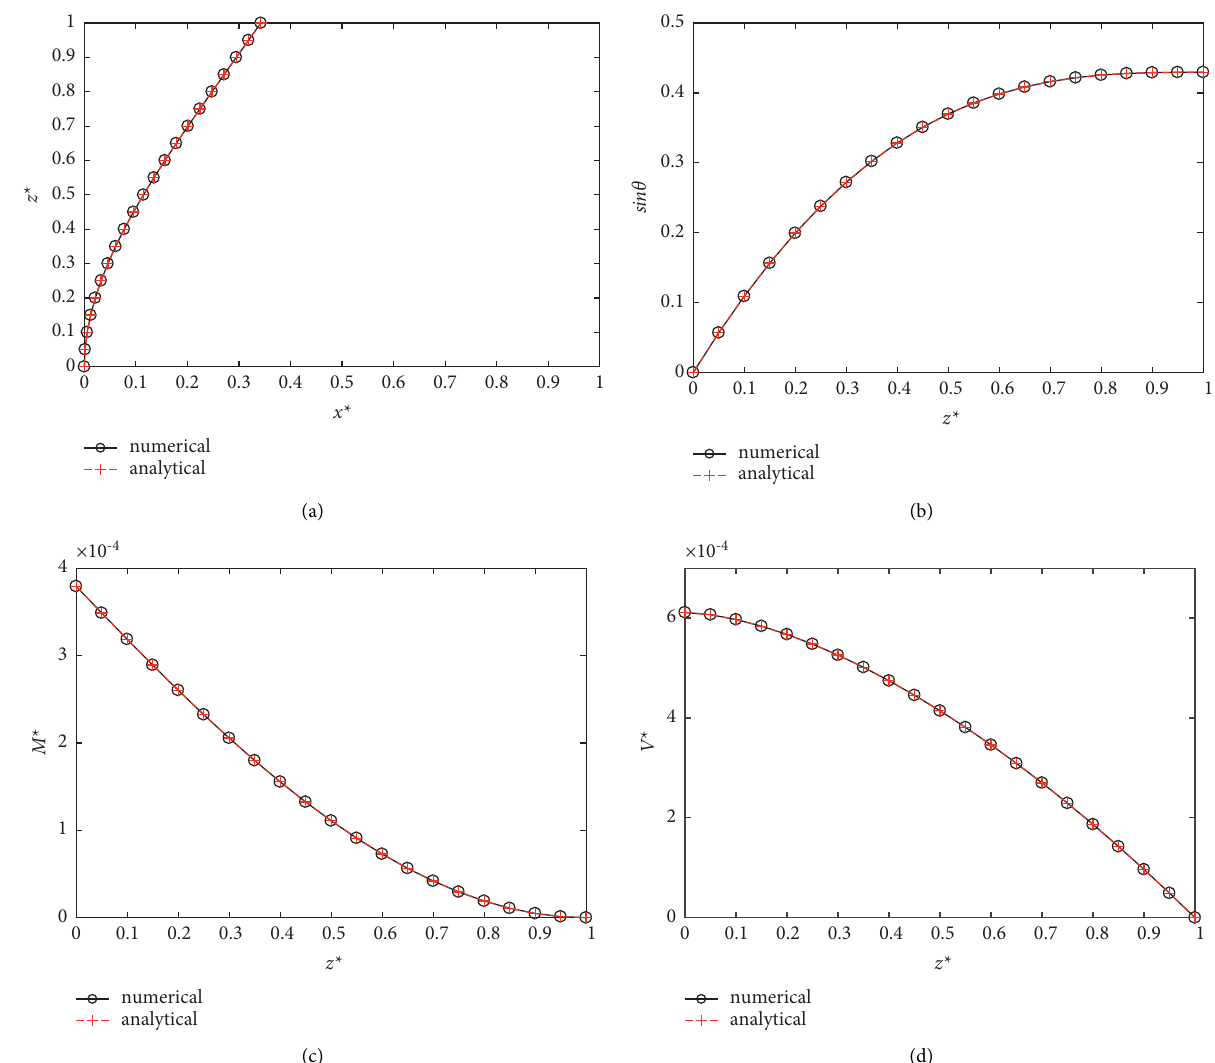
Figure 2: Deflection curve, sine of the deflection angle sin θ , bending moment M ∗ , and shear V ∗ of the cantilever beam versus z ∗